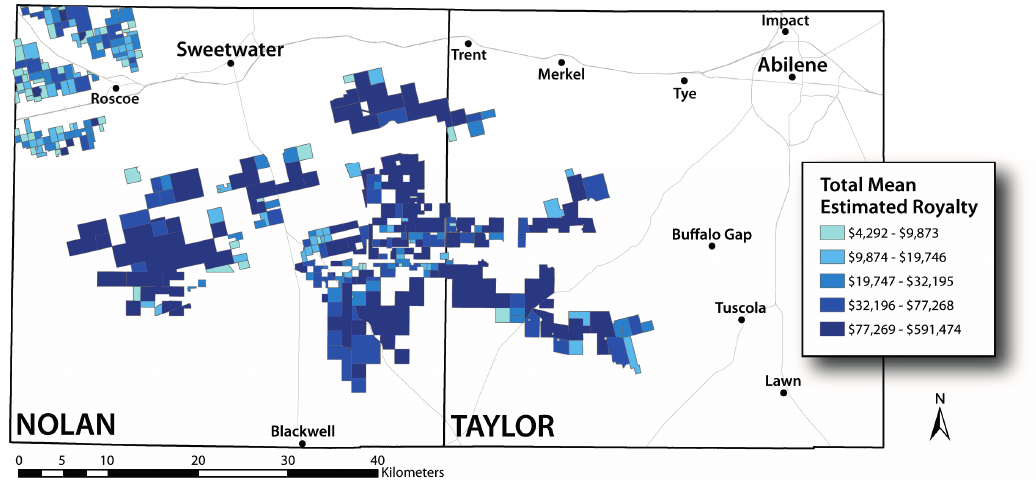
Figure 3. Spatial distribution of estimated royalties per landholder per year in Nolan and Taylor